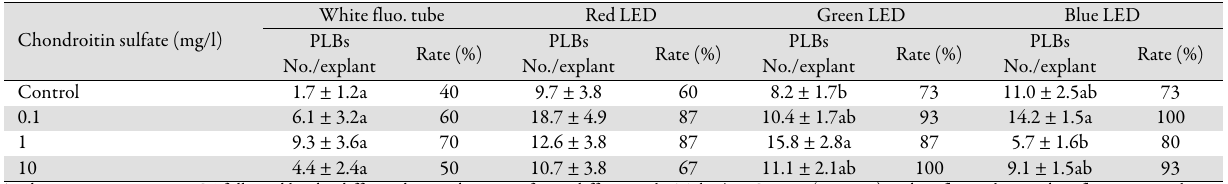
Table 2. In vitro growth of C. finlaysonianum PLBs into different concentrations of chondroitin sulfate with modified MS medium, under four sources of lights White fluo. tube Red Chondroitin sulfate (mg/l)